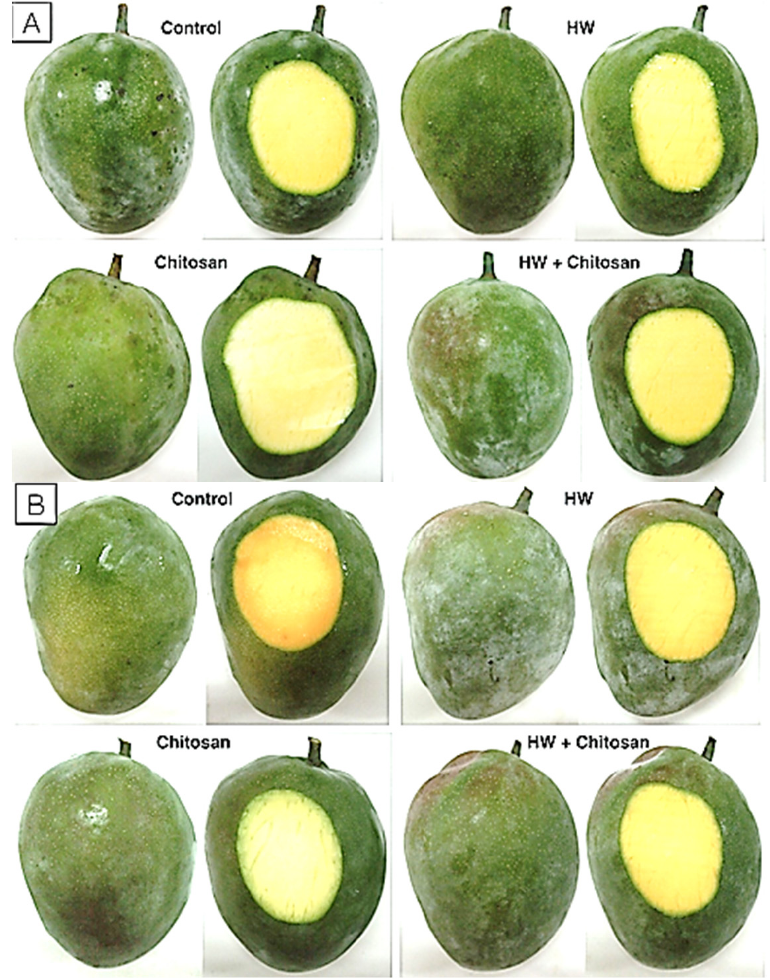
Figure 1. Visual appearance of mango fruit after 7 days ( A ) and 21 days ( B ) of storage at 13 ± 0.5 °C and 85–90% relative humidity.